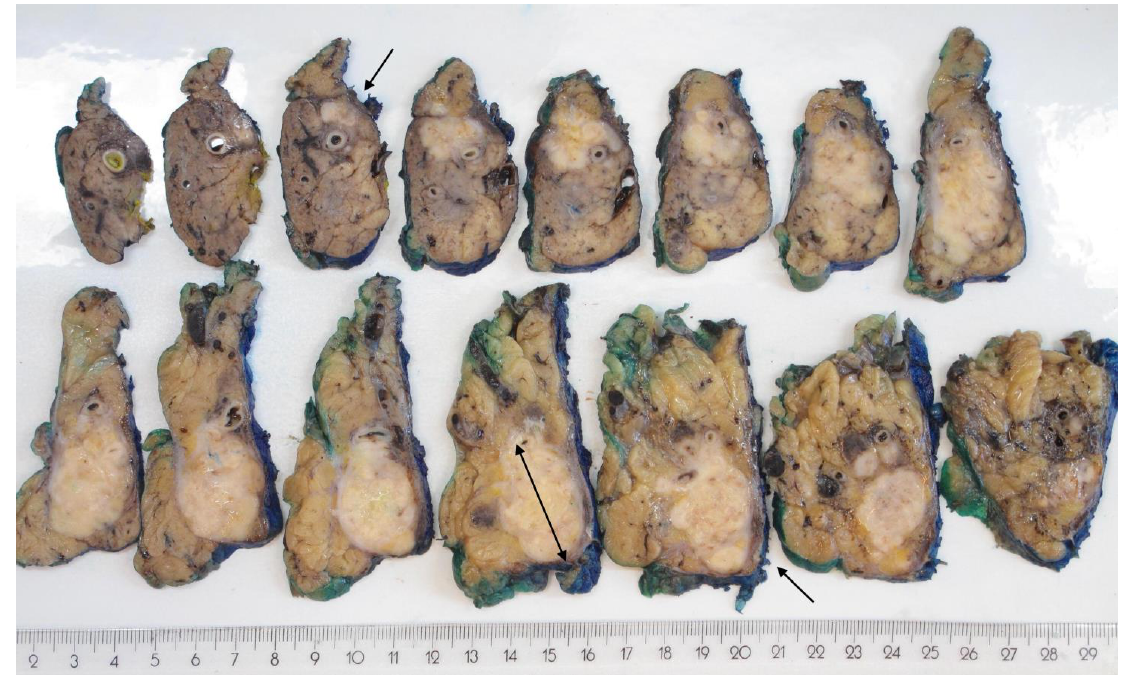
Figure 3. Oblong shape of pancreatic cancer in the body/tail. The 15 sagittal slices of a distal pan- createctomy specimen are laid out in sequential order from upper left to lower right. Tumour tissue